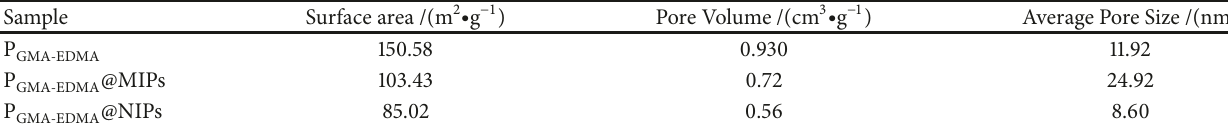
and P GMA @MIPs from nitrogen adsorption-desorption analysis. - EDMA - EDMA